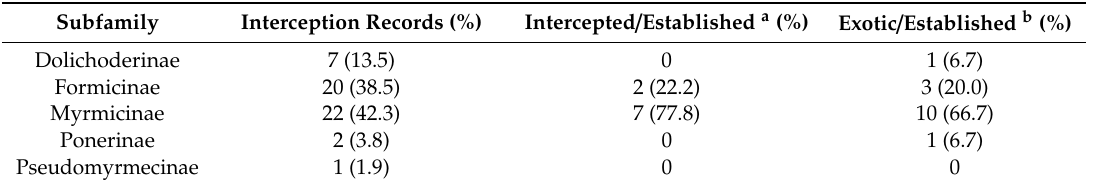
Table 3. The number of ant species from di ff erent subfamilies intercepted by BAPHIQ and the number of exotic ant species established in Taiwan. Subfamily Interception Records (%) Intercepted / Established a (%) Exotic / Established b (%)